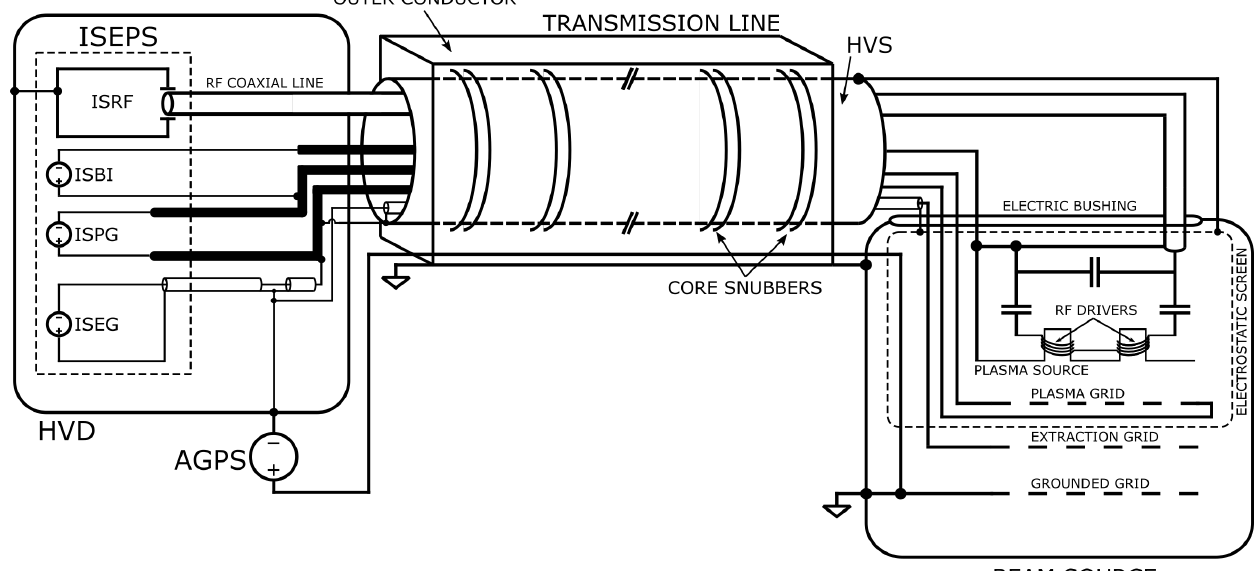
Figure 1. Representation of the overall electrical system of SPIDER. From left to right: AGPS, HVD and ISEPS—transmission line—beam